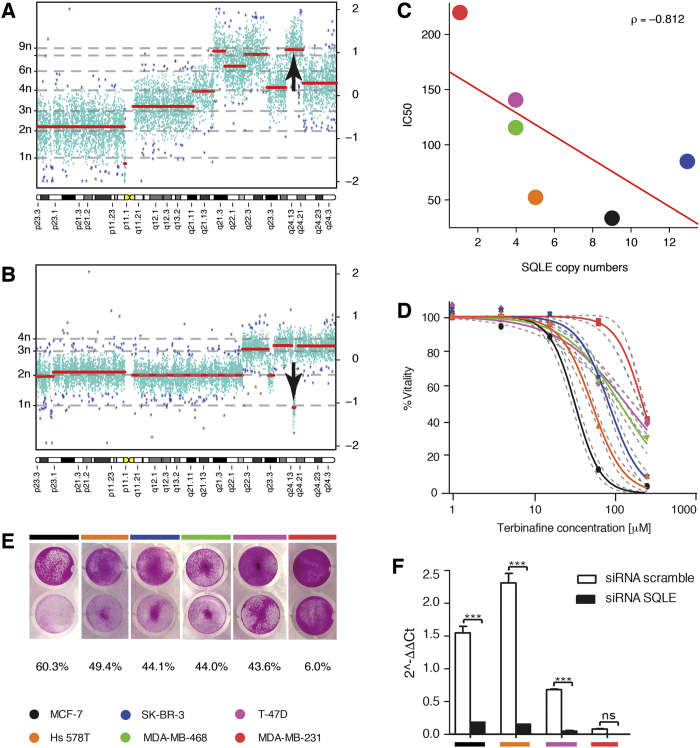
The cytotoxic action of the SQLE inhibitor terbinafine is associated with SQLE copy dosage in breast cancer cell lines.The chromosome 8 karyogram of breast cancer cell lines with the lowest (MCF-7) (A), and highest (MDA-MB-231) (B), IC50 for terbinafine are reported: along the x-axis are chromosomal coordinates, left y-axis shows the absolute copy number for segmented regions (thick red lines), and right y-axis reports log2 ratios. Turquoise points are individual probes used for segmentation, whereas dark blue asterisks are array outliers. A vertical thick black arrow points toward SQLE locus in both karyograms. Terbinafine IC50 is anti-correlated (red line representing linear regression and ρ being Spearman’s correlation coefficient) with SQLE copy dosage (C), with a greater than 7-fold difference between least and most sensitive cell line (D), dashed grey lines representing 95% confidence intervals). Sulforhodamine B coloration shows the residual cell mass upon 48 hours of terbinafine treatment (E). Silencing efficiency by SQLE-directed siRNA was always greater than 90% in treated lines (***P < 0.001, whiskers represent S.E.M.) (F). Color codes for cell lines are reported in the bottom left of the figure.